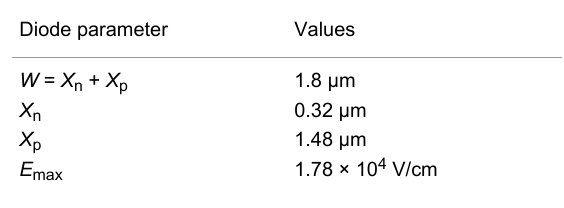
Table 1: Values of several diode parameters calculated from the C – V